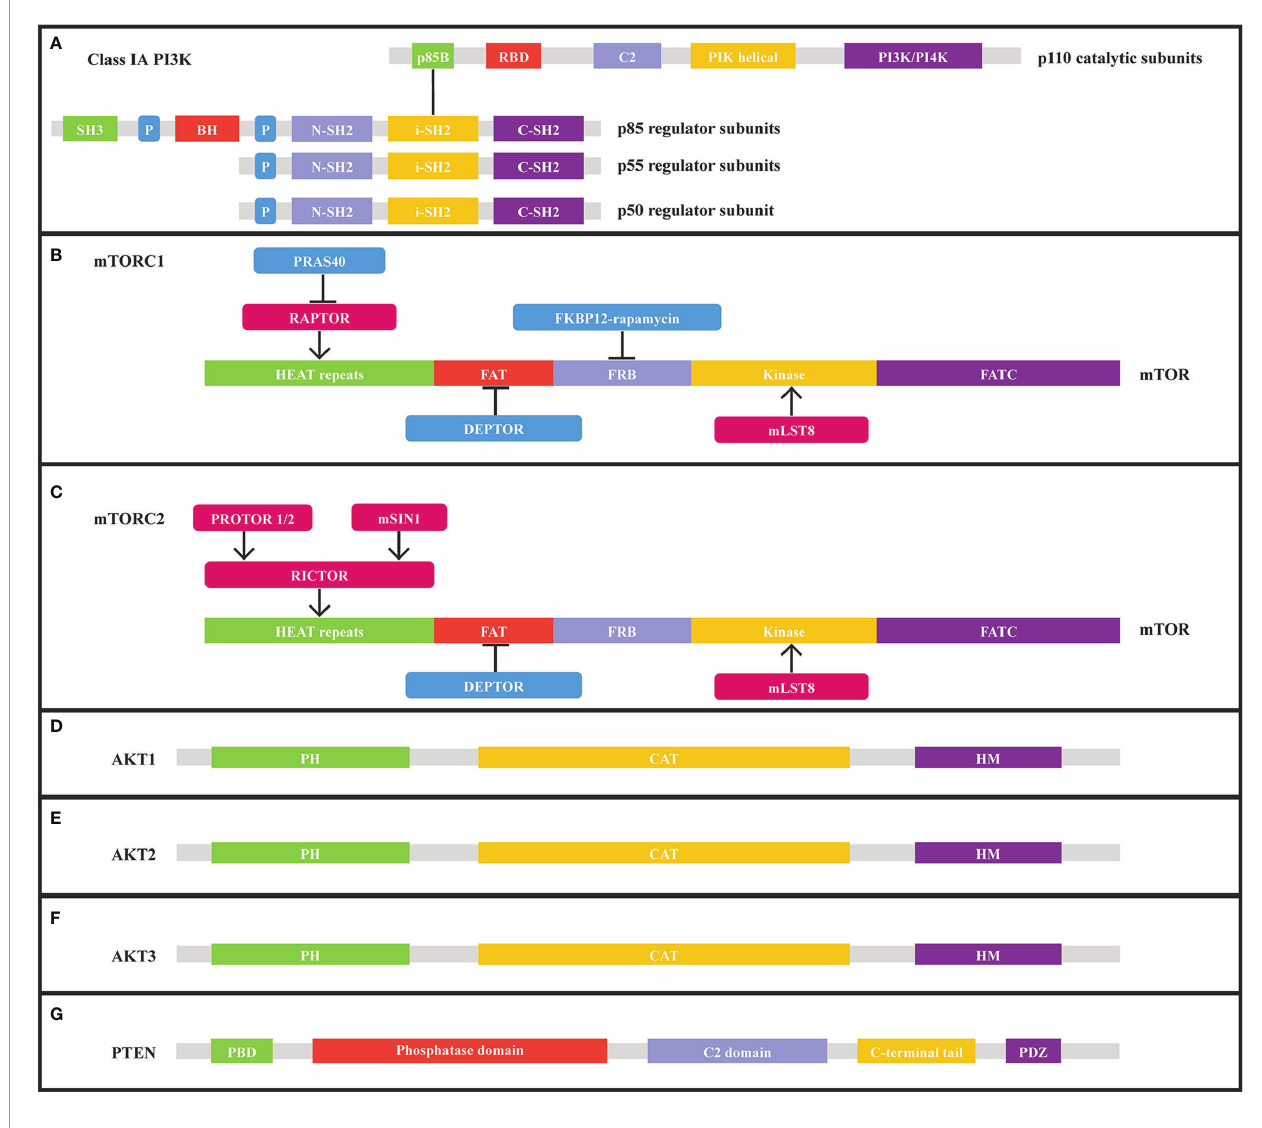
FIGURE 2 | Structure of class IA PI3K, mTORC1, mTORC2, AKT1, AKT2, AKT3, and PTEN from Uniprot.org. (A) class IA PI3K consists of catalytic and regulatory subunits. (B) mTORC1 subunits and corresponding binding sites on mTOR. (C) mTORC2 subunits and corresponding binding sites on mTOR. (D) Structure of AKT1. (E) Structure of AKT2. (F) Structure of AKT3. (G) Structure of PTEN. RBD, Ras binding domain; P, proline-rich domain; BH, breakpoint cluster homology domain; C2, membrane-interacting domain; iSH2, inter-SH2 domain; FRB, FKBP12-rapamycin-binding; HEAT, Huntingtin/Elongation factor 3/a subunit of protein phosphatase2A/TOR1; mSIN1, mammalian stress-activated; PH, pleckstrin homology; CAT, catalytic domain; HM, hydrophobic